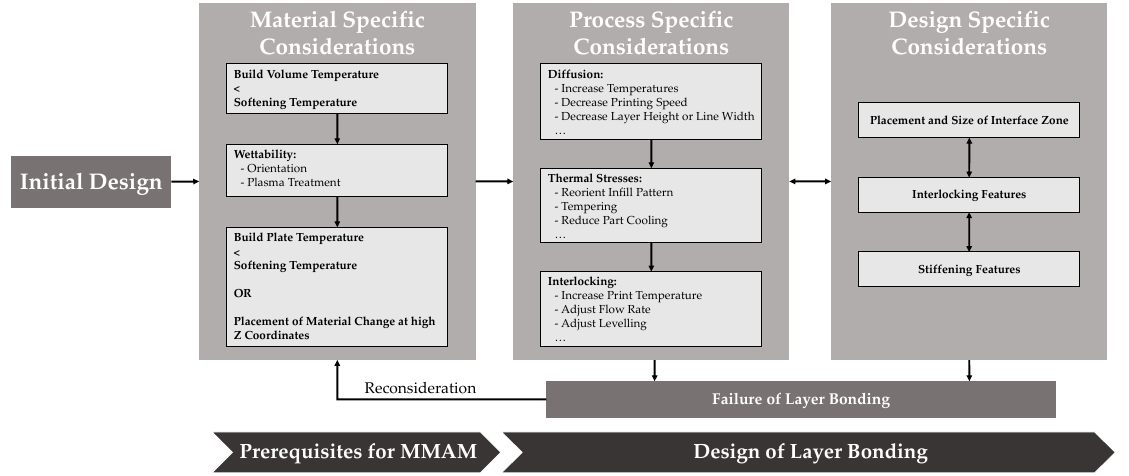
Figure 14. Proposed decision aid for designing of MMAM Parts.